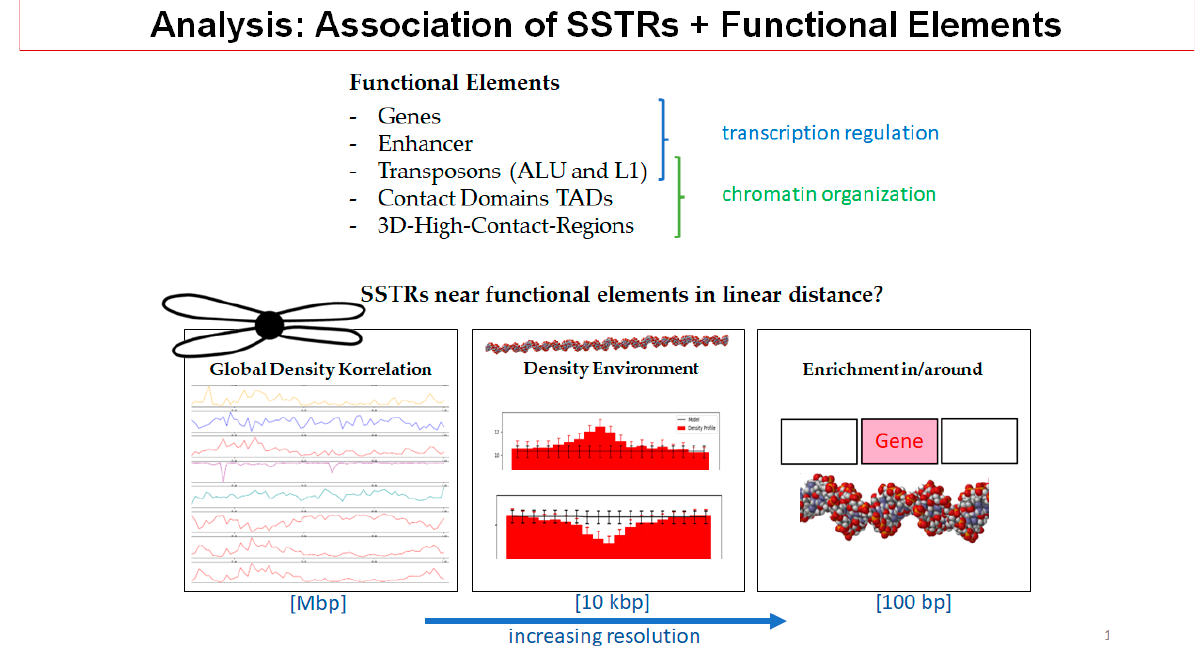
Figure 21. The correlation of SSTRs along a DNA sequence may be assessed with several functional elements, e.g., genes or transposons and on several levels of resolution along the chromosomal sequence. (Note: This figure is a modified figure that was originally published under CC-BY license in [209]).